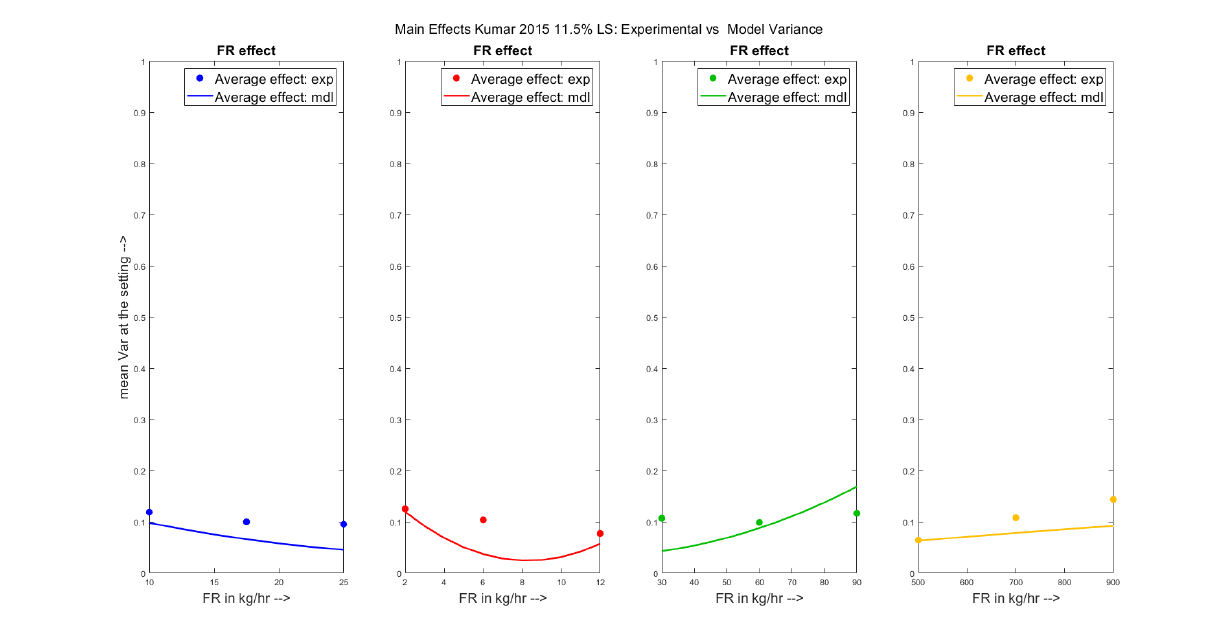
Figure 6. Experimental results vs. Model predictions: Main effects of varied parameters on variance for the Kumar et al. 2015 [21]